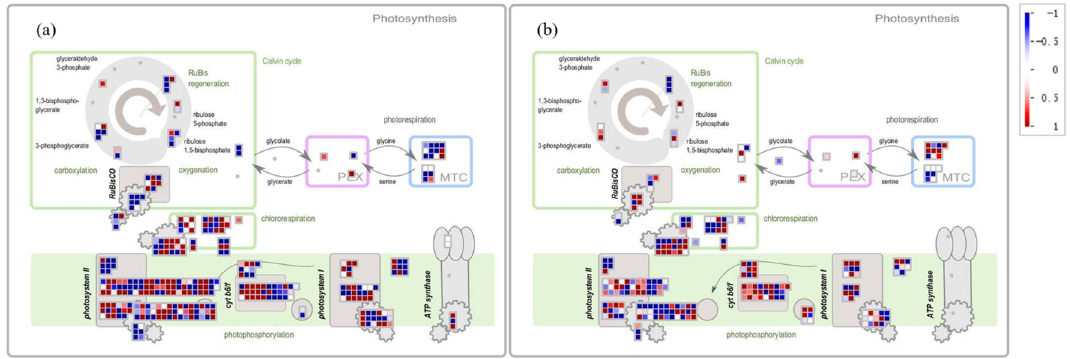
Figure 6. Differential gene expressions in the photosynthetic pathway under ( a ) low temperature stress and ( b ) high temperature stress. The shades of the colours indicate the levels of differential expression, and each square represents a differentially expressed